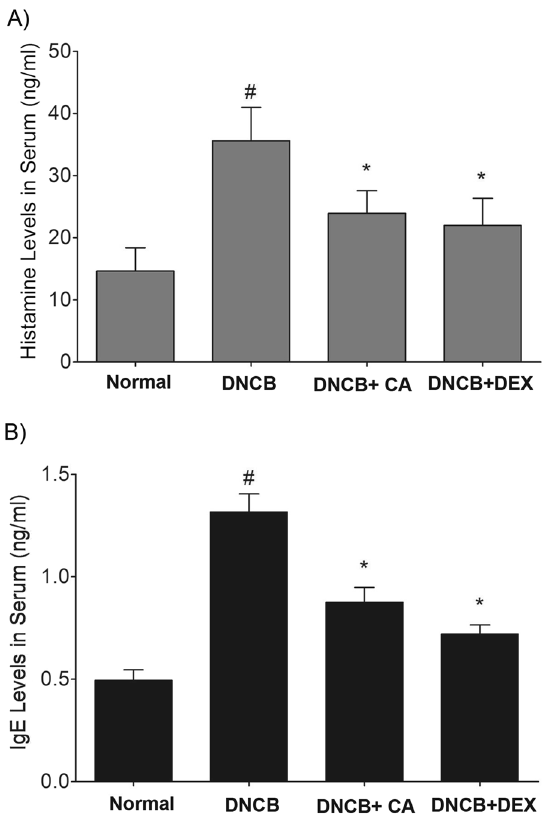
Fig. 3 Effect of CA on the histamine and IgE levels in the DNCB‑induced AD in mice. Blood samples were collected and the levels of serum histamine ( A ) and IgE ( B ) in the indicated groups were measured using ELISA. The data represents the mean independent experiments ( # p < 0.05 vs. control group, * p < 0.05 vs. DNCB‑treated